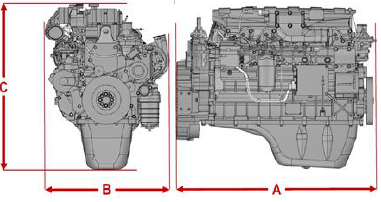
Fig. 11. Location of generating sets and motor bogies